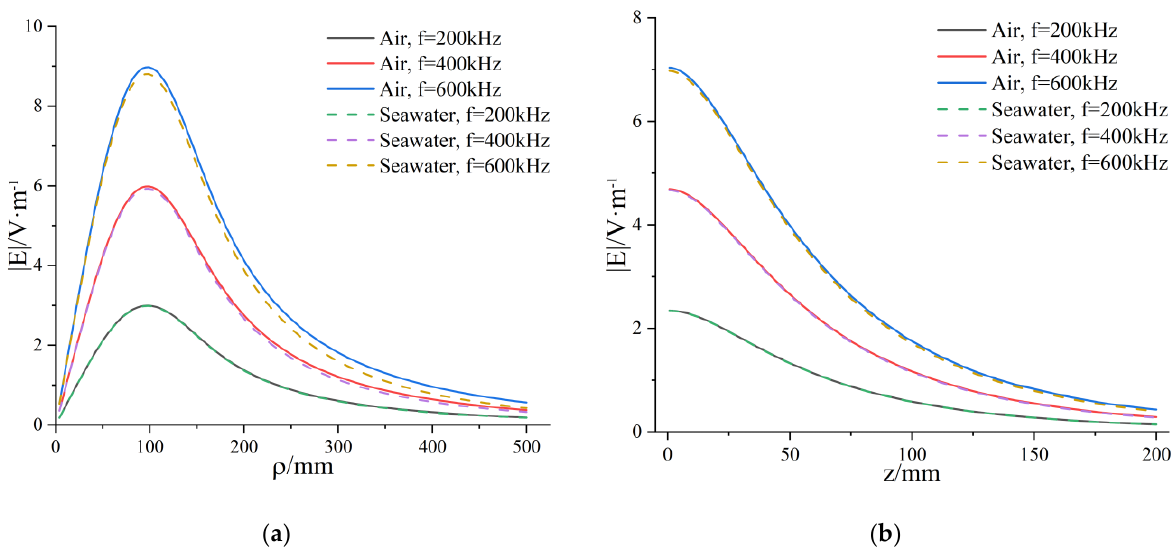
Figure 7. Modulus of electric field intensity generated by planar coil in the ( a ) radial direction ( b ) axial direction.